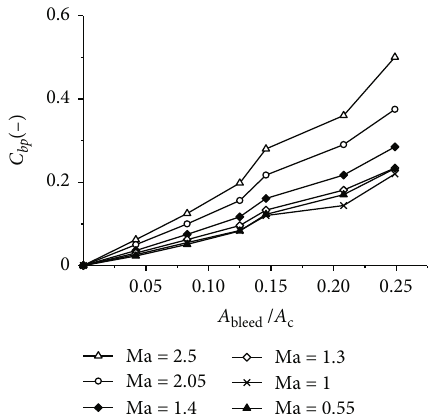
Figure 1: Relationship between inlet bleed drag coe ffi cient and air fl